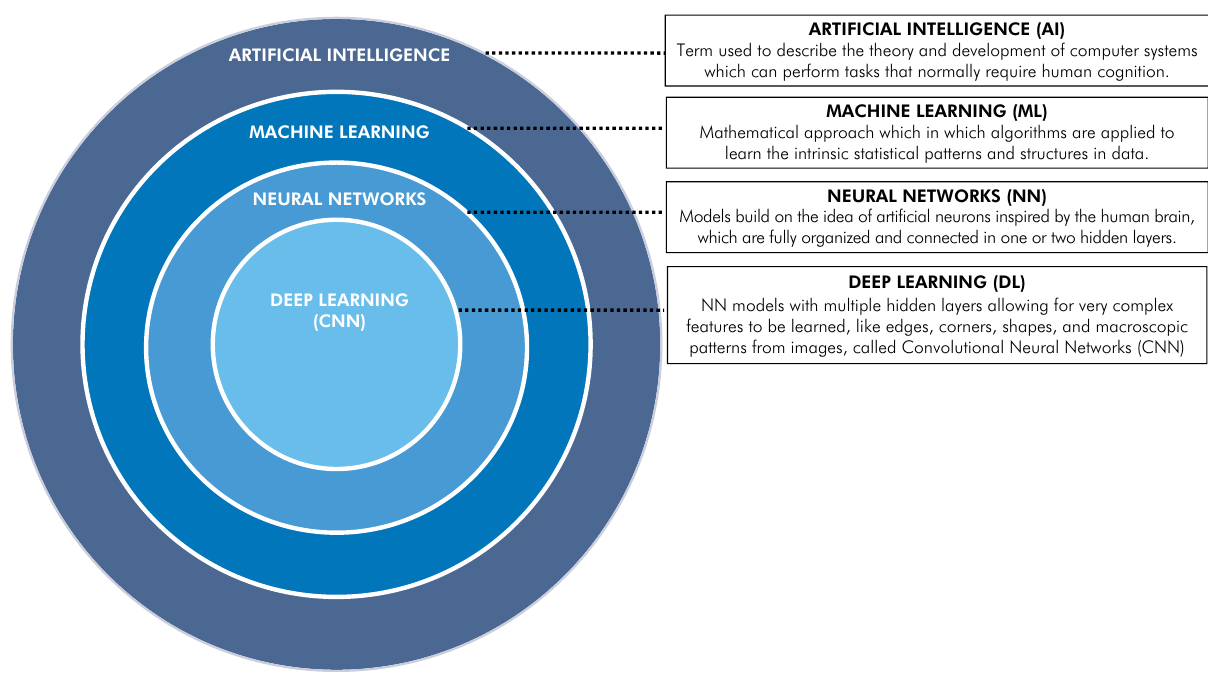
Figure 2. Hierarchy of